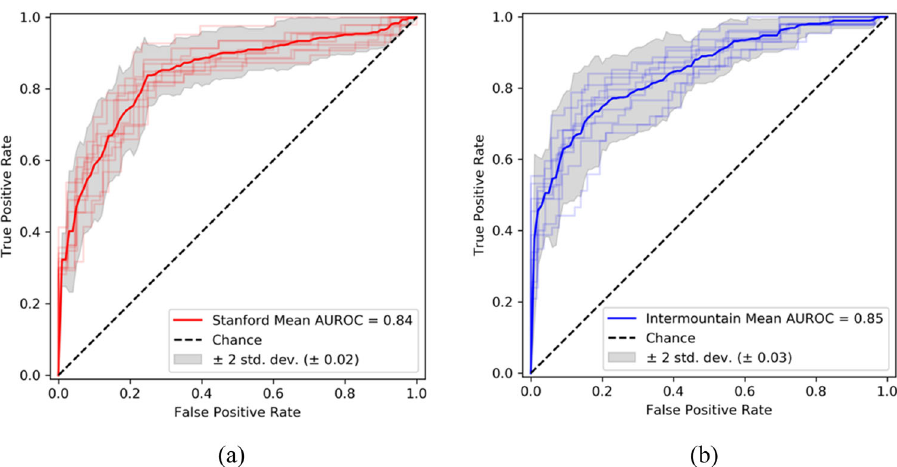
Fig. 1 PENet performance on independent test datasets. Receiver operating characteristic curve (ROC) with bootstrap con fi dence intervals on Stanford internal test set ( a ) and Intermountain external test set ( b